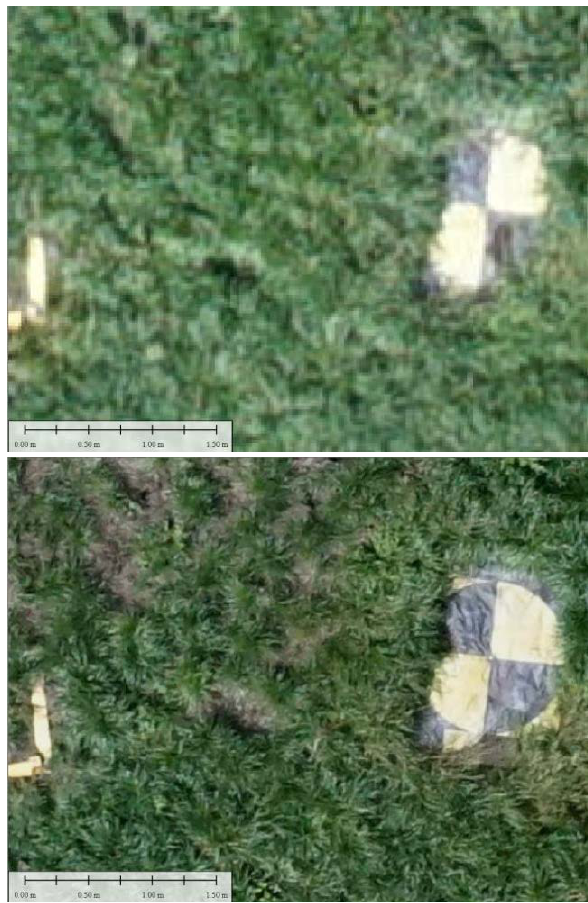
Figure 5: Demonstration of different GSDs (top: 2.4 cm, bottom: 1 cm).